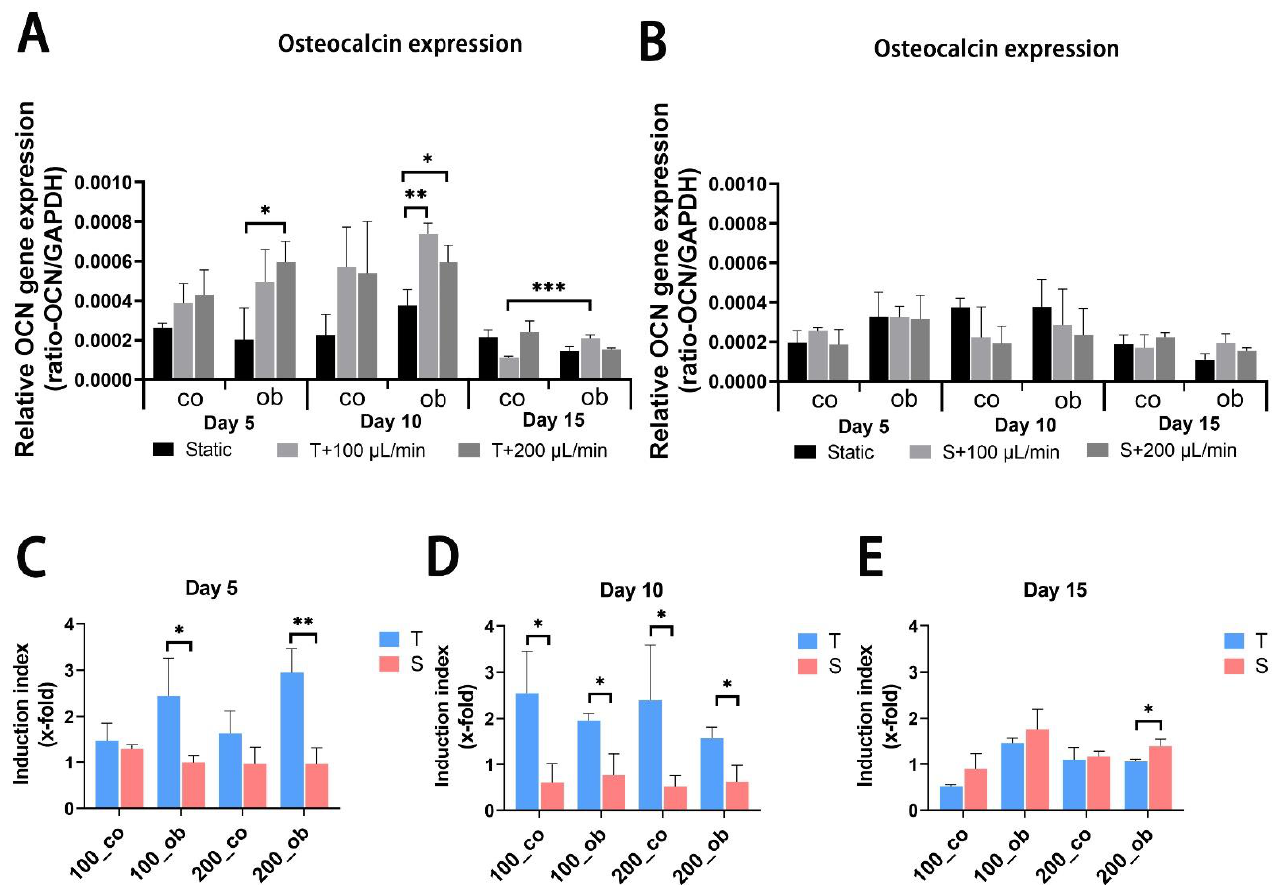
Figure 8. Relative gene expression levels of osteocalcin (OCN) in JPCs cultured within β -TCP scaffolds after 5, 10 and 15 days of osteogenic differentiation under the indicated conditions. mRNA expression levels under ( A ) tangential and ( B ) sigmoidal configuration were quantified and normalized to the housekeeping gene GAPDH. To calculate induction indices, gene expression levels were normalized to untreated (co) or osteogenically induced (ob) JPCs under static condition. Induction indices of tangential (T) and sigmoidal (S) configuration after ( C ) 5 days, ( D ) 10 days and ( E ) 15 days of culture were calculated. The gene expression and induction values are given as means ± SD. Gene expression levels under different culture conditions (dynamic conditions and static condition) were compared using one-way ANOVA followed by Tukey’s multiple comparisons tests. For comparing levels